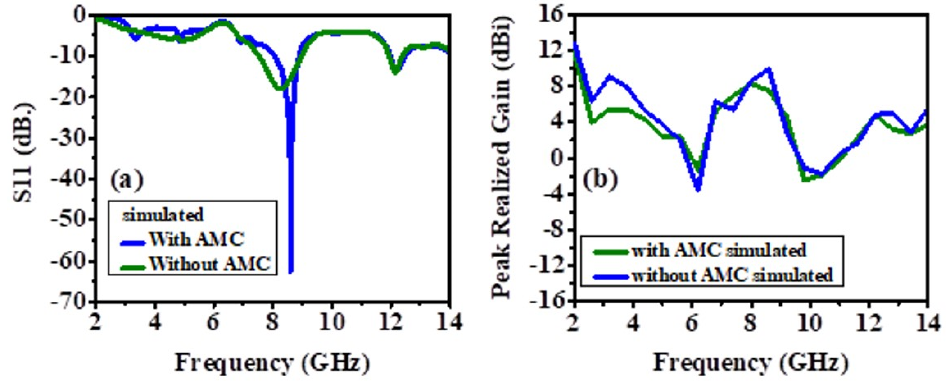
Figure 3. ( a ) The simulated reflection coefficient (S11) AMC and without AMC, ( b ) the simulated maximum gain of the prototype with AMC and without AMC.